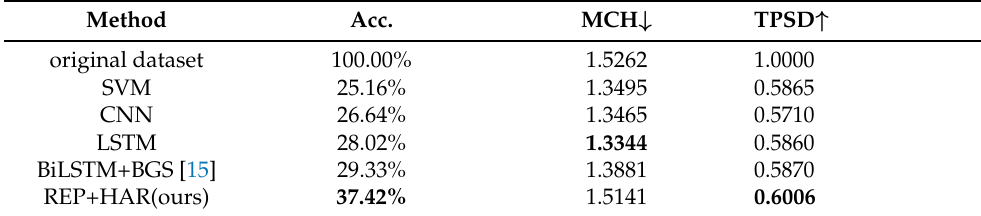
Table 1. The results of all the models in our harmonization task. The results are the average over five runs.